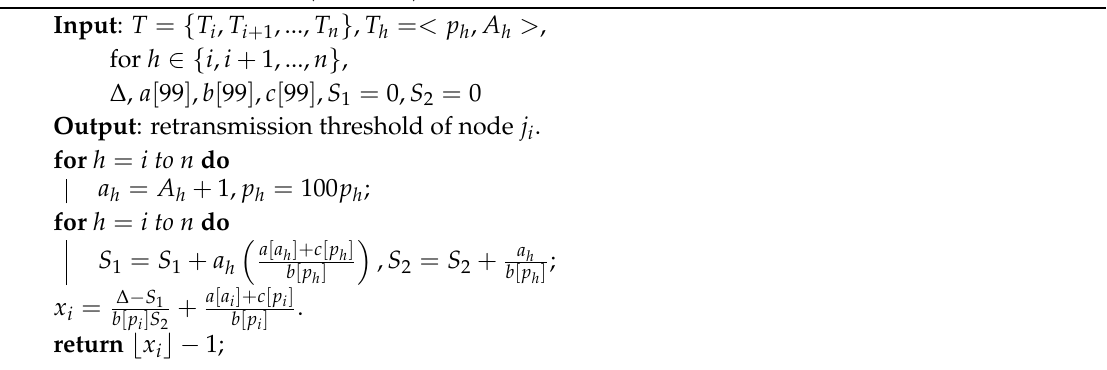
Algorithm 3: Lagrange Multiplier-based Distributed Approximation Algorithm for the retransmission threshold